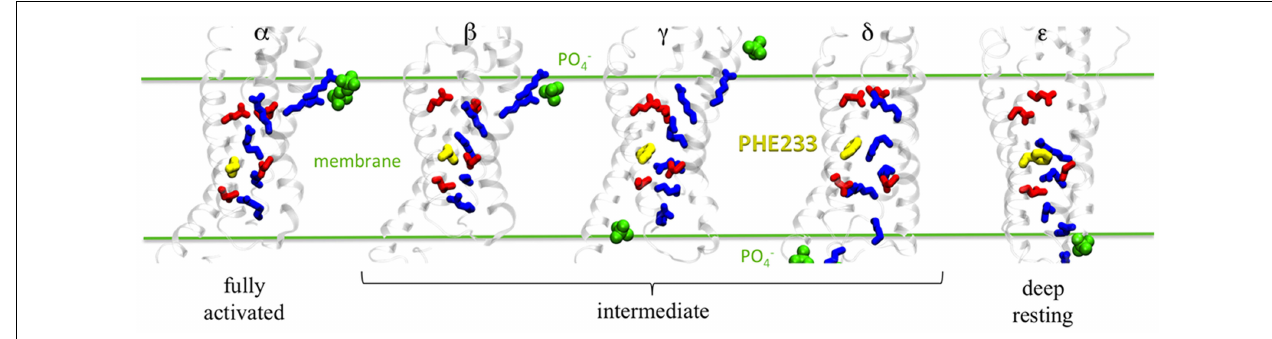
FIGURE 2 | Salt bridge network in each Kv1.2 conformation ( α to ε ). Basic residues are in blue and acidic residues in red. F233 is represented as yellow spheres and lipid PO − groups within 6Å of the basic residues are shown in green. Adapted from Delemotte et al. (2011). 4